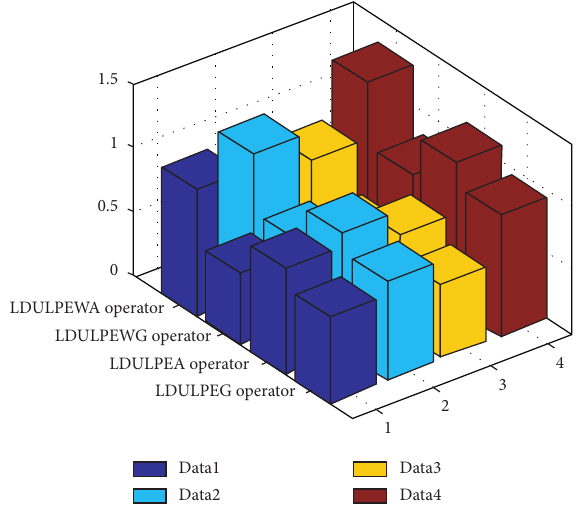
Figure 2: Geometrical expressions of the values in Table